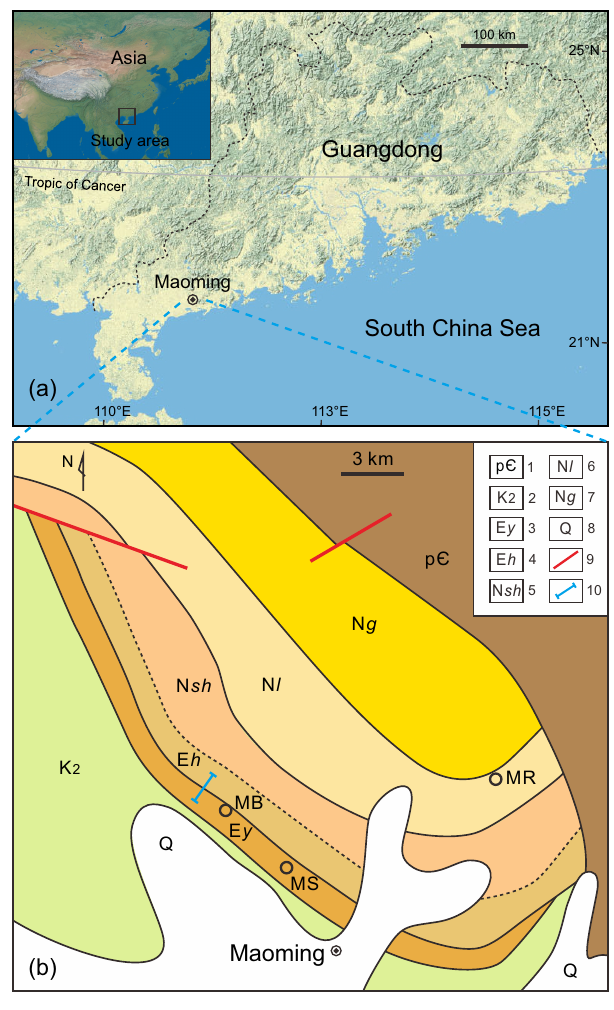
Figure 1. Location and regional geology of the study area. Panel ( a ): map showing the location of the Maoming Basin, Guangdong Province, southern China. Panel ( b ): simplified geological map of the Maoming Basin: 1. Precambrian; 2. Upper Cretaceous; 3. Youganwo Fm.; 4. Huangniuling Fm.; 5. Shangcun Fm.; 6. Laohul- ing Fm.; 7. Gaopengling Fm.; 8. Quaternary; 9. fault; 10. Jintang section investigated. MR, MB, and MS mark the sites where sam- ples were collected for a magnetostratigraphic study by Wang et al. (1994). See text for